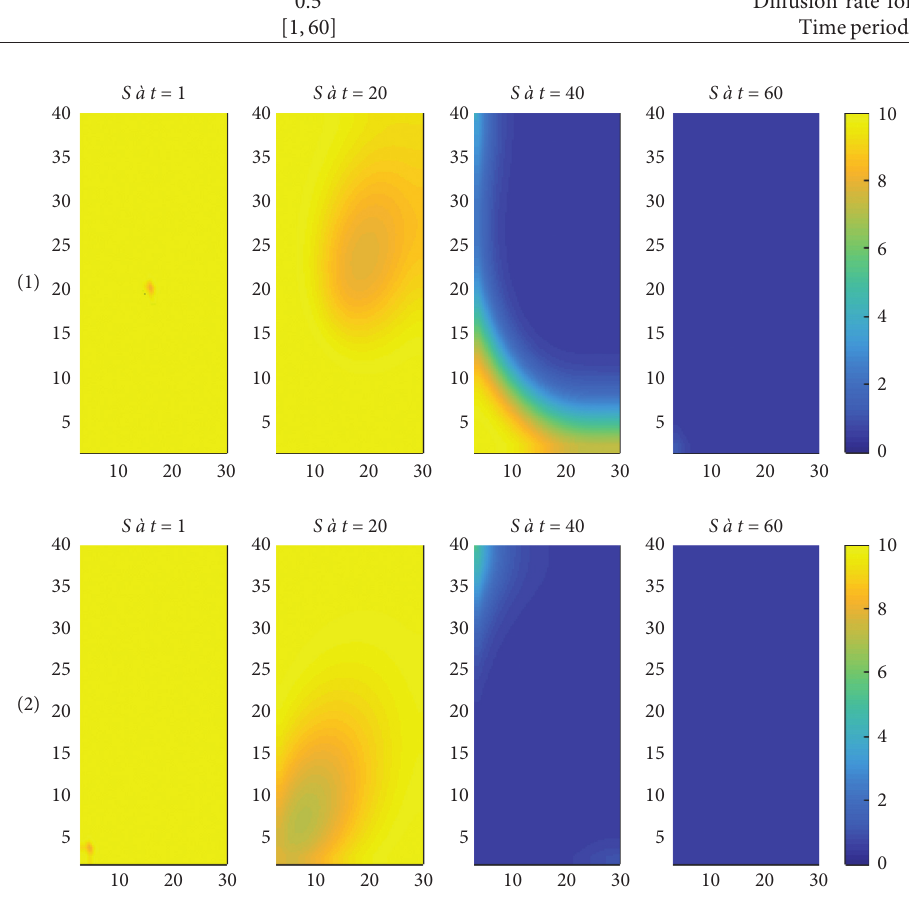
Figure 1: Susceptible behavior within Ω without control.